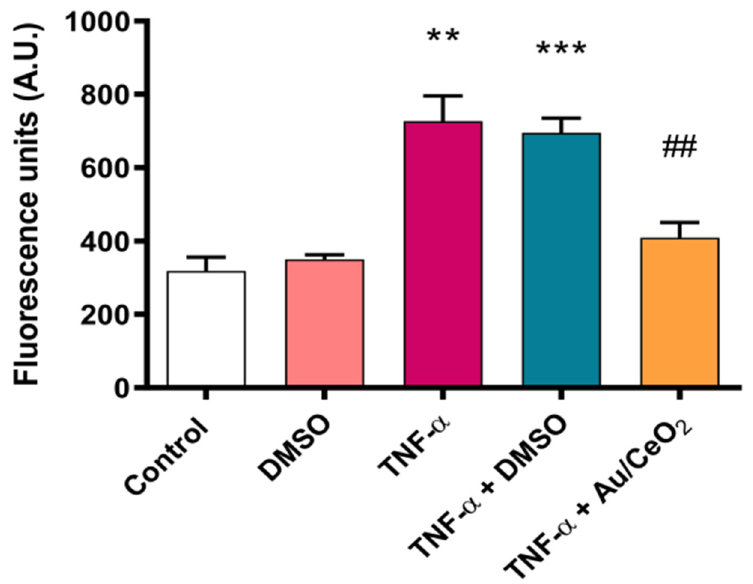
Figure 6. Au/CeO 2 (3 h, 0.02 mg/mL) effects in leukocyte adhesion to HUVEC monolayer stimulated with TNF- α (5 ng/mL). ** p < 0.01 vs. not stimulated; *** p < 0.001 vs. not stimulated; ## p < 0.01 vs. stimulated.